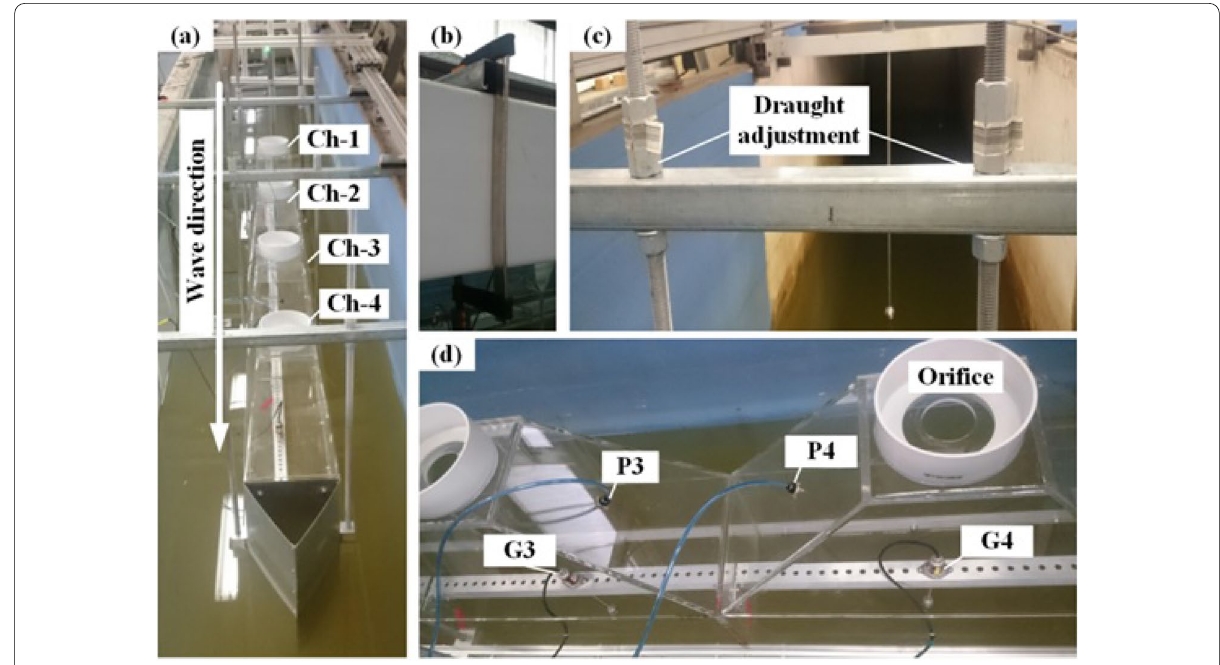
Figure 3 Views of wave flume and physical model in wave